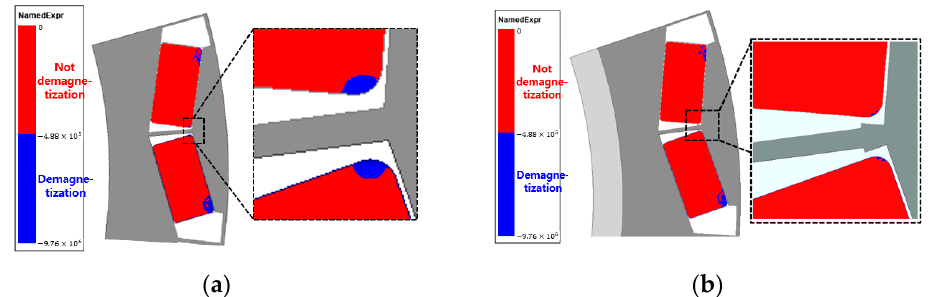
Figure 11. Irreversible demagnetization area before and after inserting a steel plate in bridge: ( a ) Basic model, ( b ) Irreversible demagnetization area.